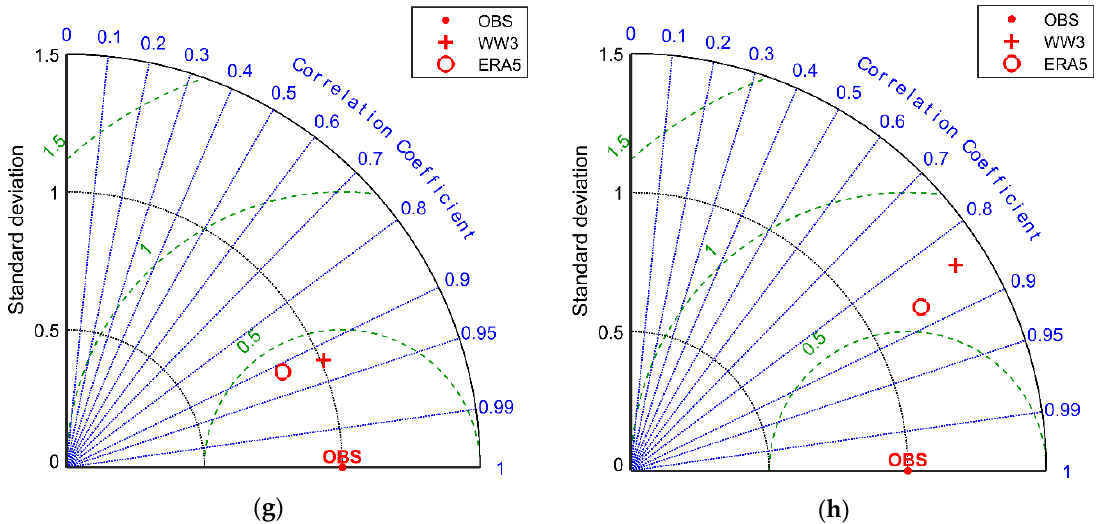
Figure 12. Normalized Taylor diagrams for: ( a , b ) the Bastia (no. 3), ( c , d ) Capo Mele (no. 5), ( e , f ) Castiglione (no. 6), ( g , h ) Giannutri (no. 8) buoys. The results are relative to Hs ( a , c , e , g ) and Tm ( b , d , f , h ). The plus (+) and circle ( ◯ ) symbols refer to the wave hindcast (here WW3) and ERA5 data (here ERA5), respectively.